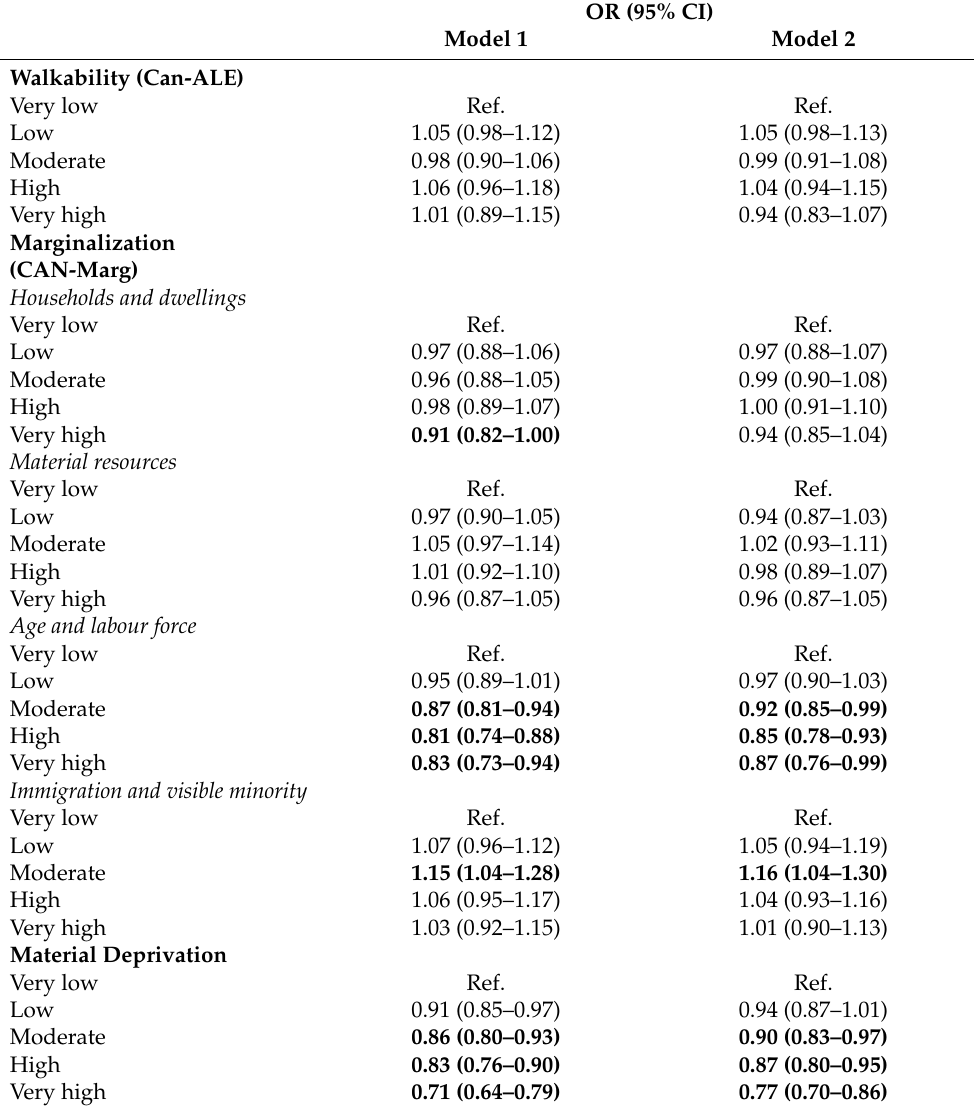
Table 2. Association of built and social environment characteristics with fruit and vegetable con- sumption in the BC Generations